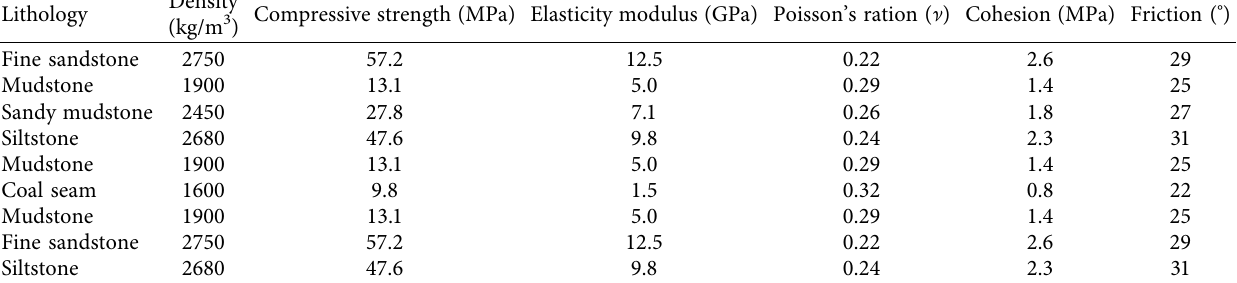
Table 1: Mechanical properties of the rock mass.